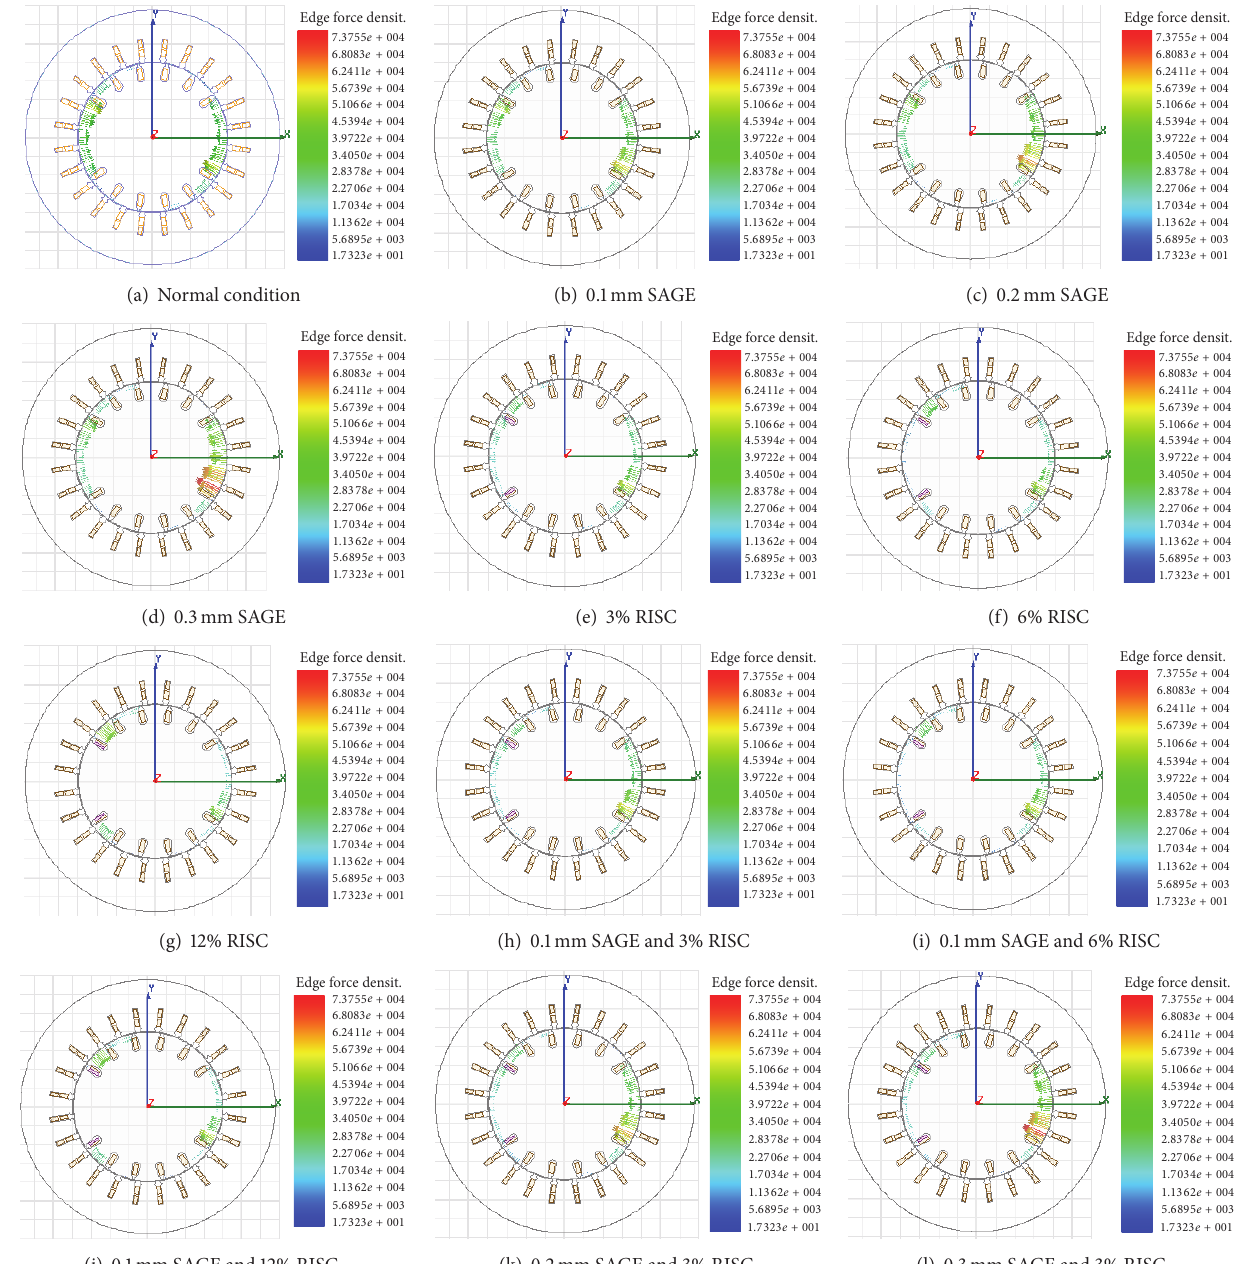
Figure 4: MPPUA distribution under different